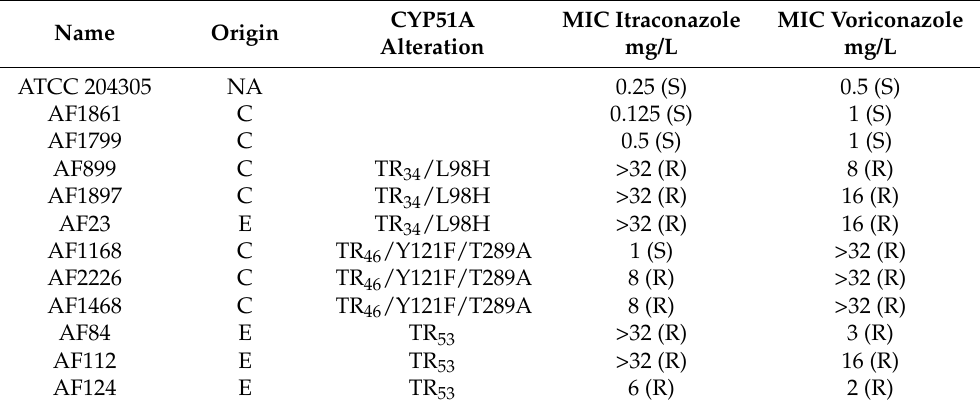
Table 1. Characteristics of